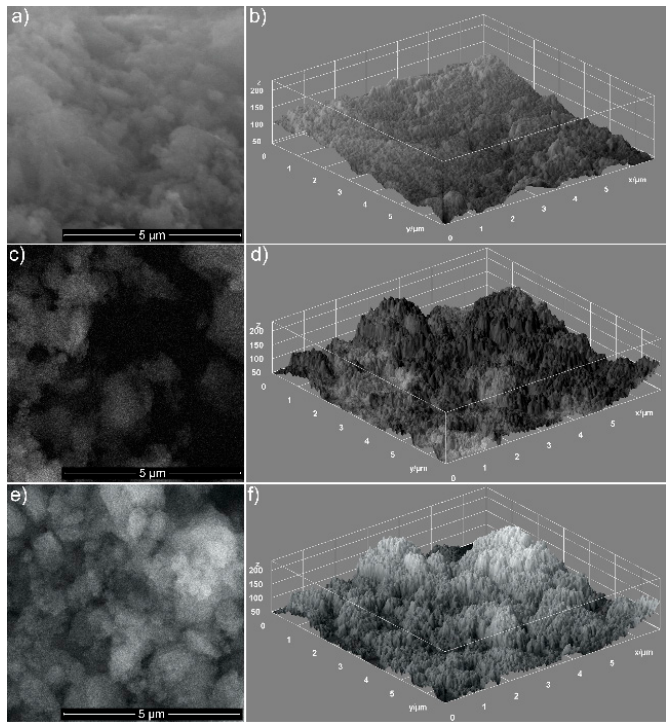
Figure 1. The SEM images of HAp ( a ), HAp-B ( c ) and HAp-L ( e ). 3D surface plot of SEM images of HAp ( b ), HAp-B ( d ) and HAp-L ( f ) samples.